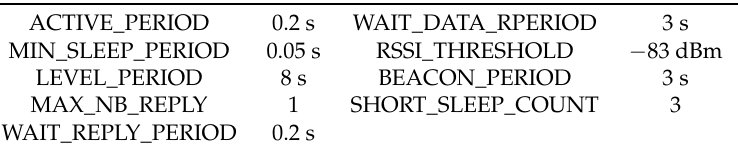
Table 1. Experiment